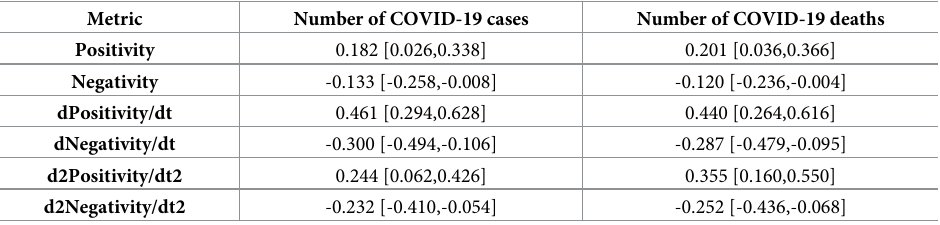
Table 1. Pearson’s correlation coefficient (5% and 95% confidence intervals in square brackets) between the smoothed rate of change in the numbers of COVID–19 cases and deaths and positivity and negativity of press releases and their first and second time derivative.